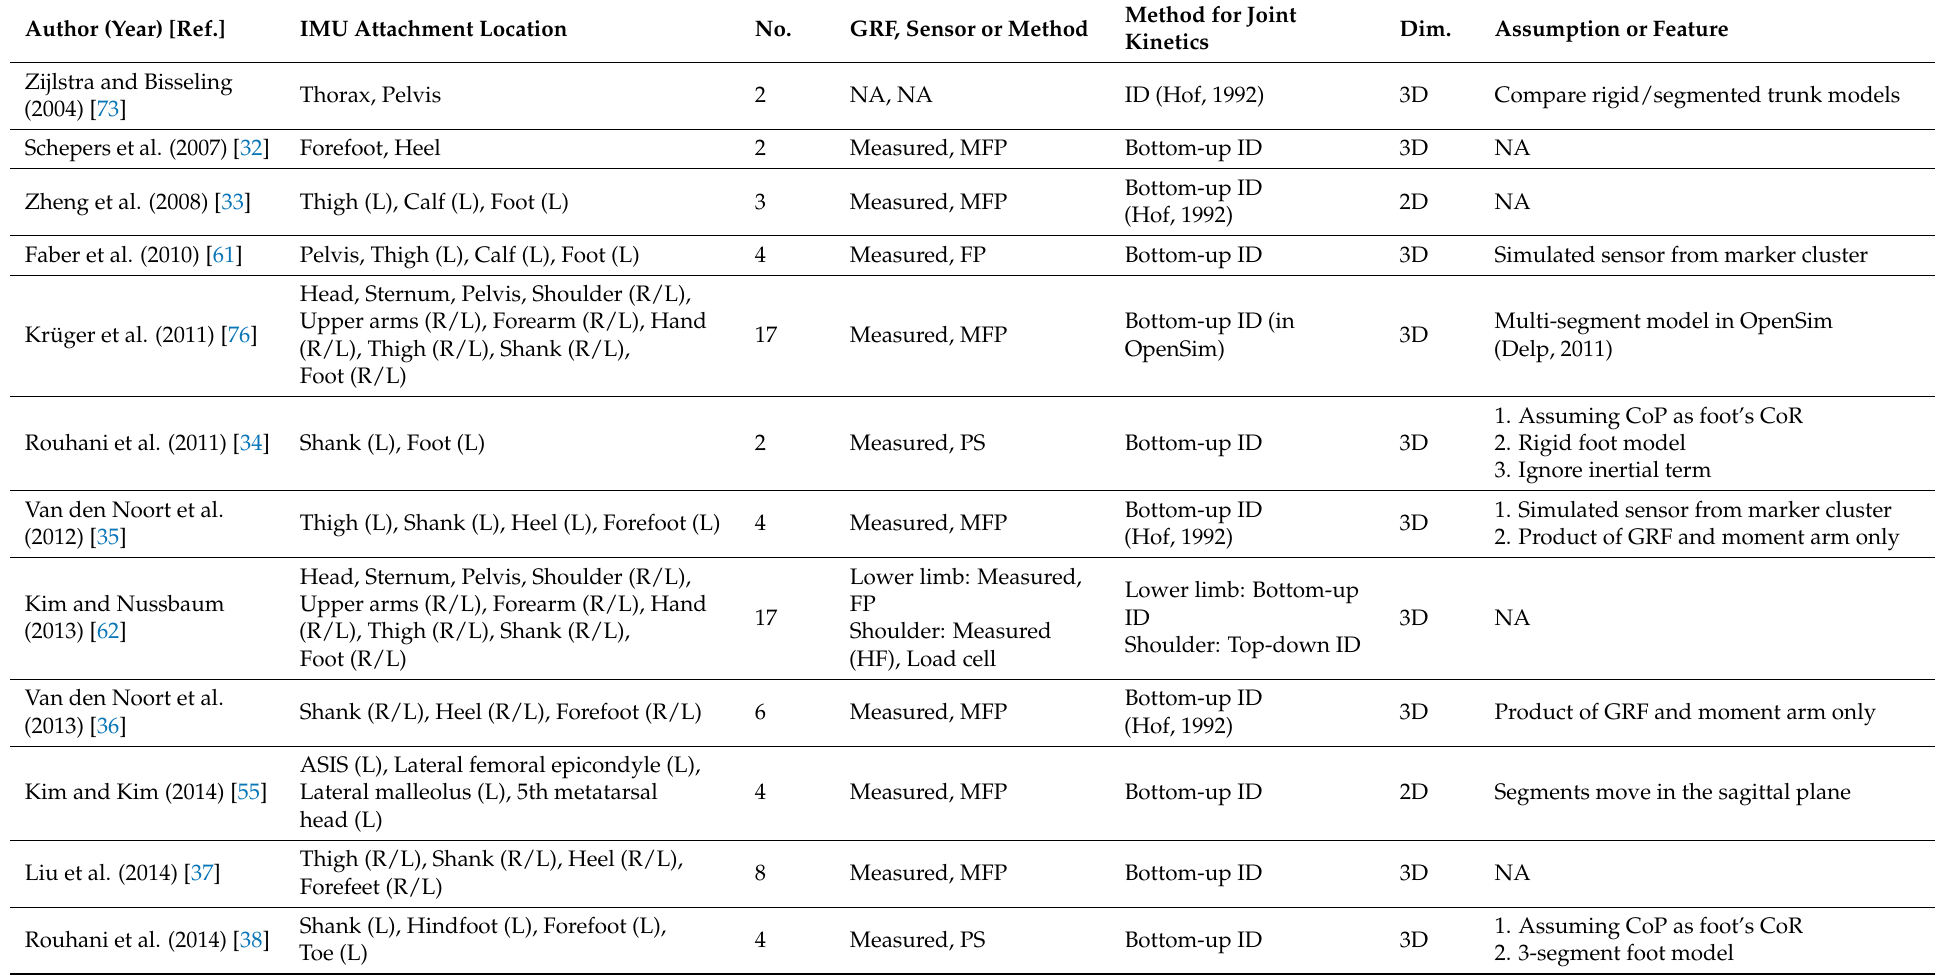
Table 3. Summary of inverse dynamics-based